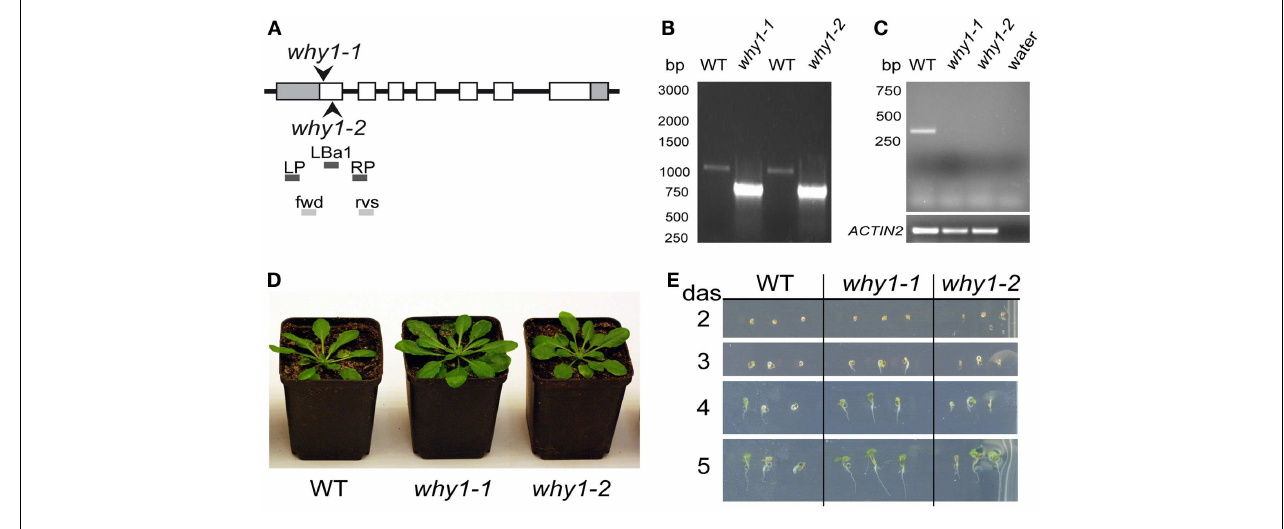
presence of WHIRLY1 mRNA in the why1-1 and why1-2 lines, respectively, cDNA derived of the two mutant lines and wildtype (WT) and the primers shown in (A) were used in a RT-PCR. Primers specific for ACTIN2 were used for loading controls. (D) Phenotype of the why1-1 and why1-2 mutants was compared to wildtype (WT) when grown under standard growth conditions. Six-week-old plants are shown. (E) Germination of why1-1 and why1-2 was compared to the wildtype (WT) under standard growth conditions.The phenotype of the seedlings was monitored 2–5days after sowing